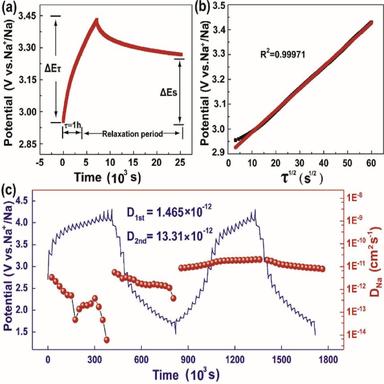
. (a) t vs E profile for a single GITT titration; (b) linear behavior of E vs t1/2; (c) GITT curves and the corresponding apparent Na-diffusion coefficients at the first two cycles between 1.6 V and 4.3 V for P2-MCC.